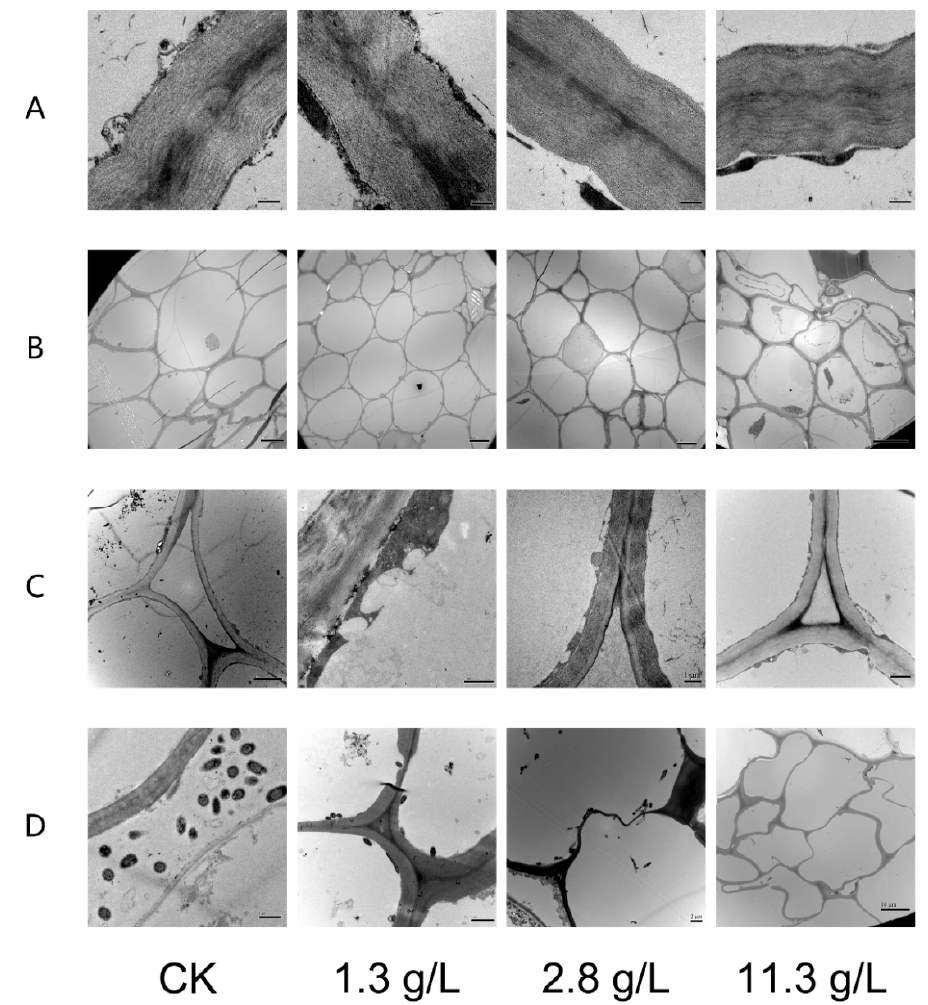
Figure 6. Effects of paclobutrazol at different concentrations on cells of O. japonicus . Effects on the cell wall ( A ), cell size and morphology ( B ), organelles ( C ), and number of bacteria ( D ).